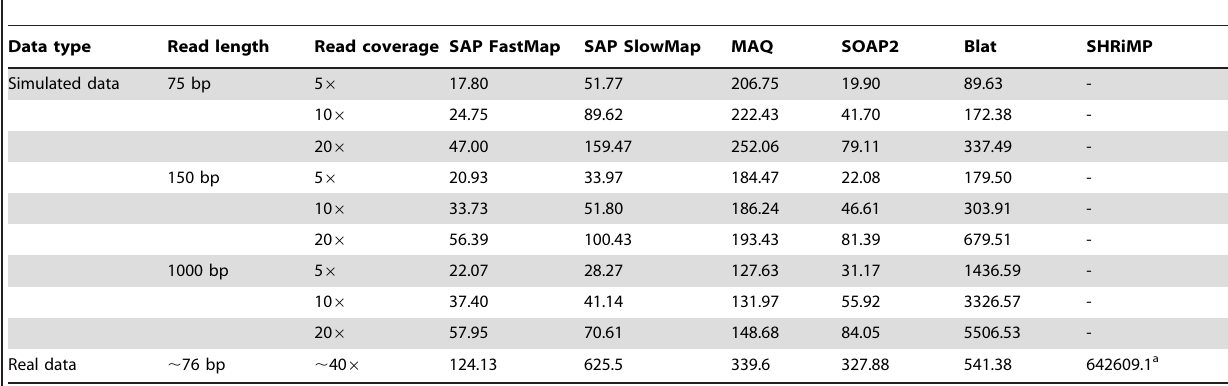
Table 1. Time-consumption by different algorithms in mapping reads from simulated data and real data